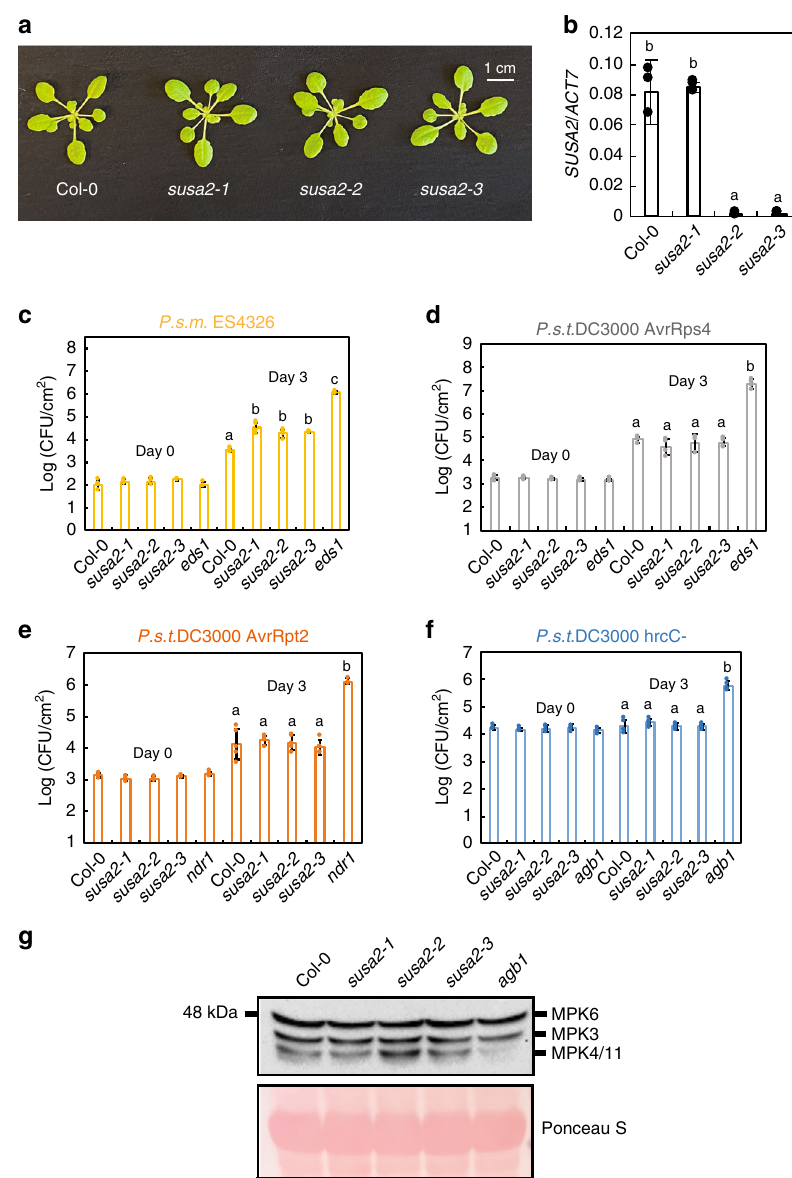
Fig. 4 Characterization of the susa2 single mutants. a Morphology of 3.5-week-old Col-0, susa2-1 , susa2-2 , susa2-3, which were grown on soil. b SUSA2 expression in the indicated plants as determined by RT-PCR and normalized to ACT7 . Error bars represent means ± SD (one-way ANOVA, SPSS Statistics, n = 3, p < 0.01). Experiments were repeated three times with similar results. c Bacterial growth of P.s.m . ES4326 in Col-0, susa2-1 , susa2-2 , susa2-3, and eds1 plants 3 days post in fi ltration. Error bars represent means ± SD (one-way ANOVA, SPSS Statistics, p < 0.01). For day 0, n = 4 for Col-0, susa2-1 , susa2-2 , and n = 3 for susa2-3 , eds1 . For day 3, n = 5 for Col-0, susa2-2 and n = 4 for susa2-1 , susa2-3 , eds1 . Experiments were repeated three times with